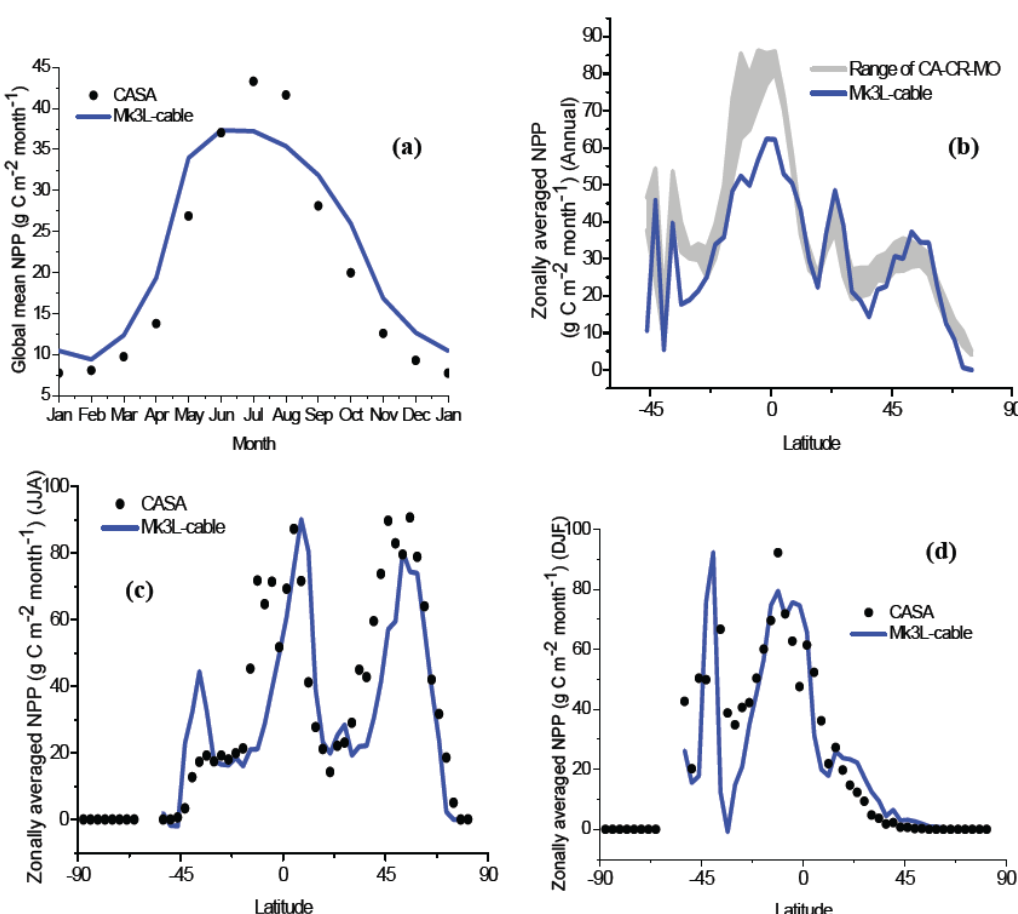
Fig. 9. Net primary productivity (gCm − 2 month − 1 ) for (a) global mean values compared with the estimate from CASA (Randerson et al., 1997); (b) annual net primary productivity simulated by Mk3L-CABLE compared with the range of estimates from CA (Randerson et al., 1997), CR (Cramer et al., 1999) and MO (Zhao et al., 2005); (c) zonally averaged JJA net primary productivity compared with CASA; and (d) zonally averaged DJF net primary productivity compared with